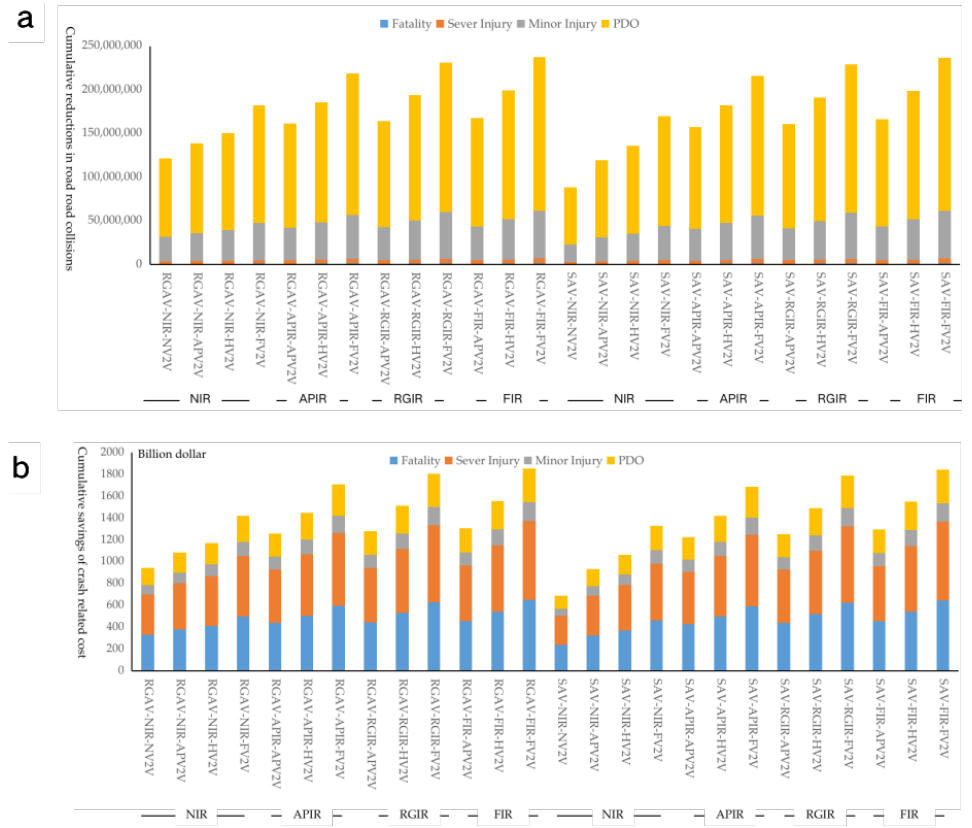
Figure 6. 2015 – 2050 cumulative reductions in road injuries and savings in crash-related economic costs for 26 synergetic scenarios. ( a ) Cumulative reductions in road fatalities, serve injuries, minor injuries, and property damages only (PDO); ( b ) cumulative savings of crash-related economic